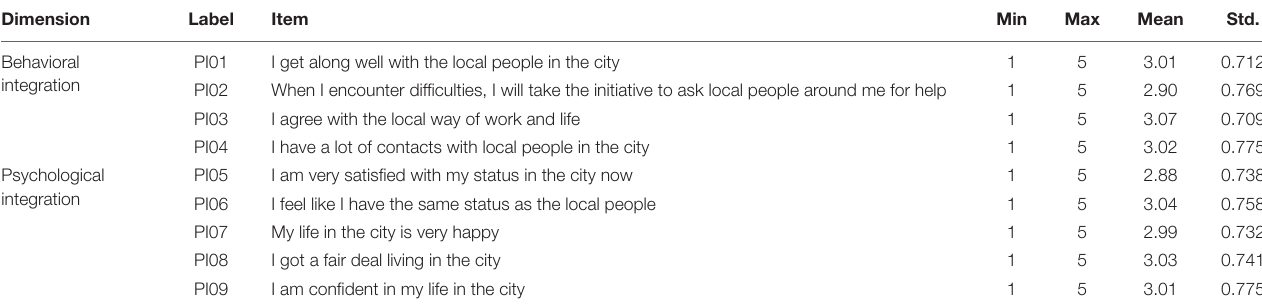
TABLE 1 | Item content and statistical description of “urban integration scale.”